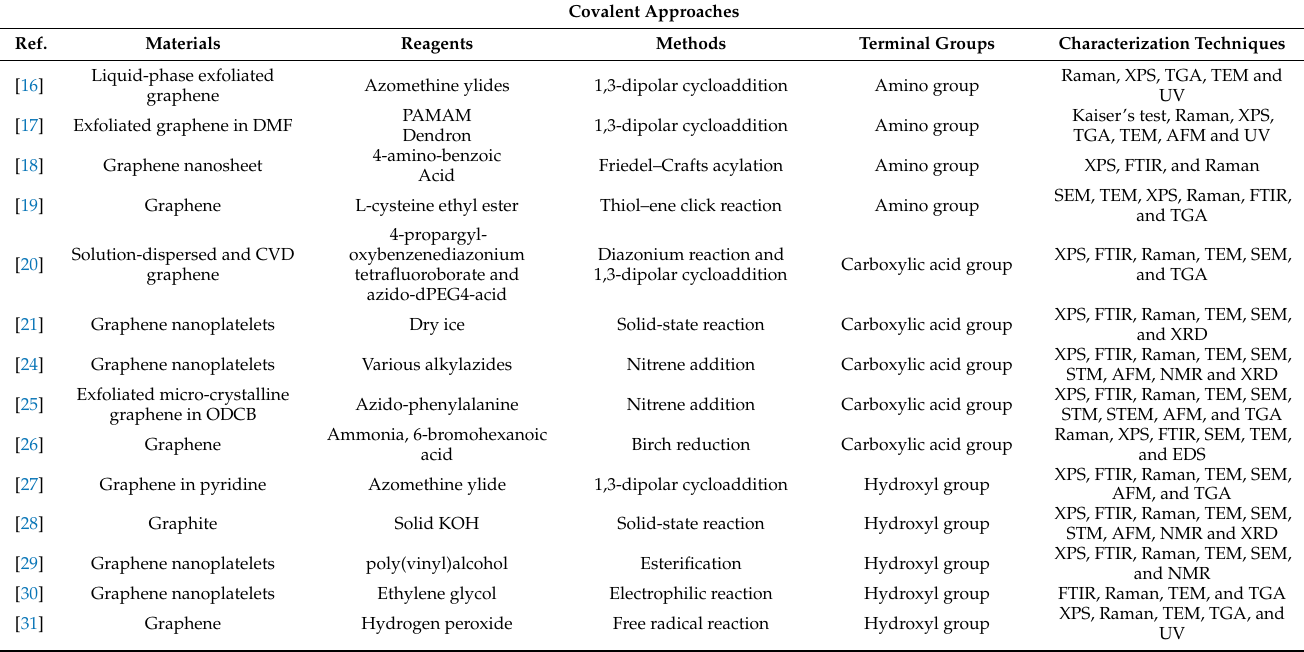
Table 1. Covalent and noncovalent functionalization approaches of GNPs.